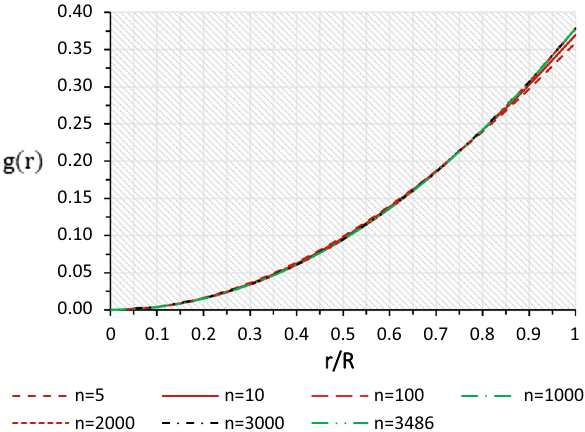
Fig. 1 Behaviour of g ( r ) vs. radial coordinate r / R with different val- ues of n for LMC X −